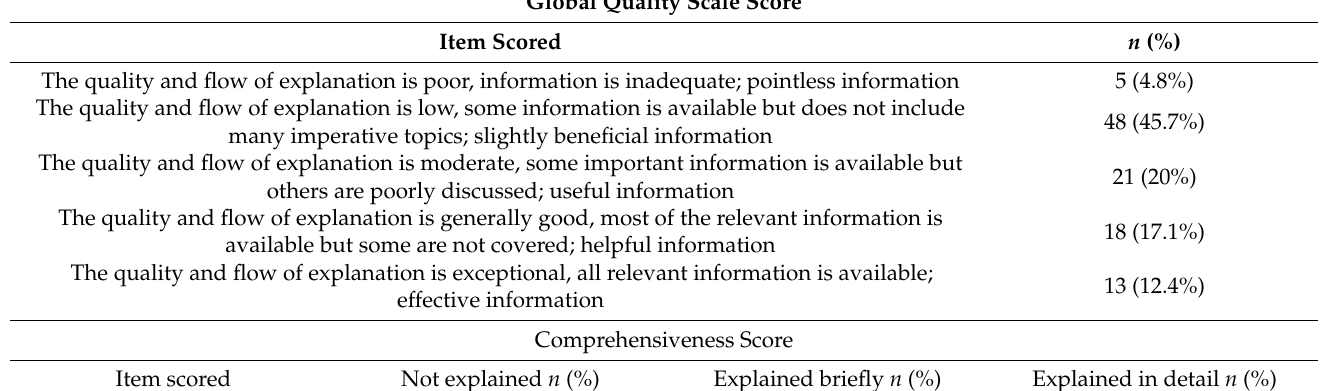
Table 2. Frequency and percentage of the global quality scale score, the comprehensiveness score, and the total video score. Global Quality Scale